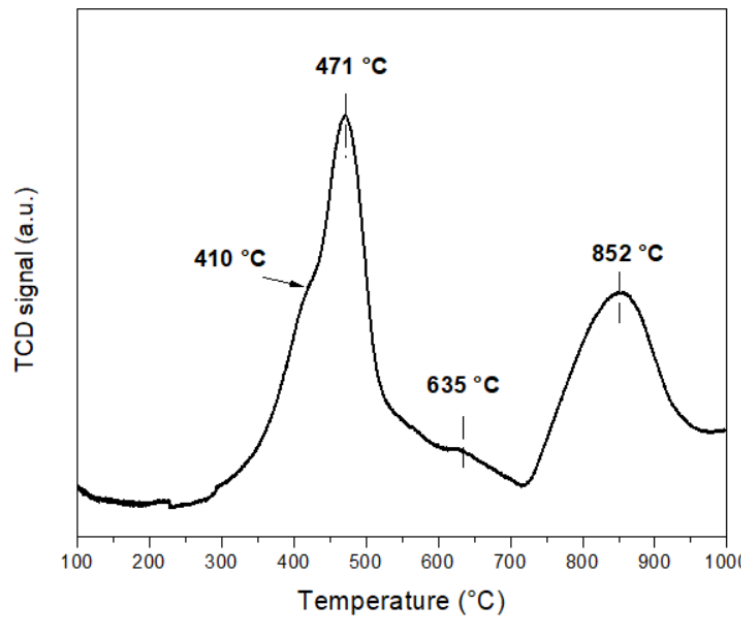
Figure 4. H 2 -TPR curve of monolith catalyst as a powder.